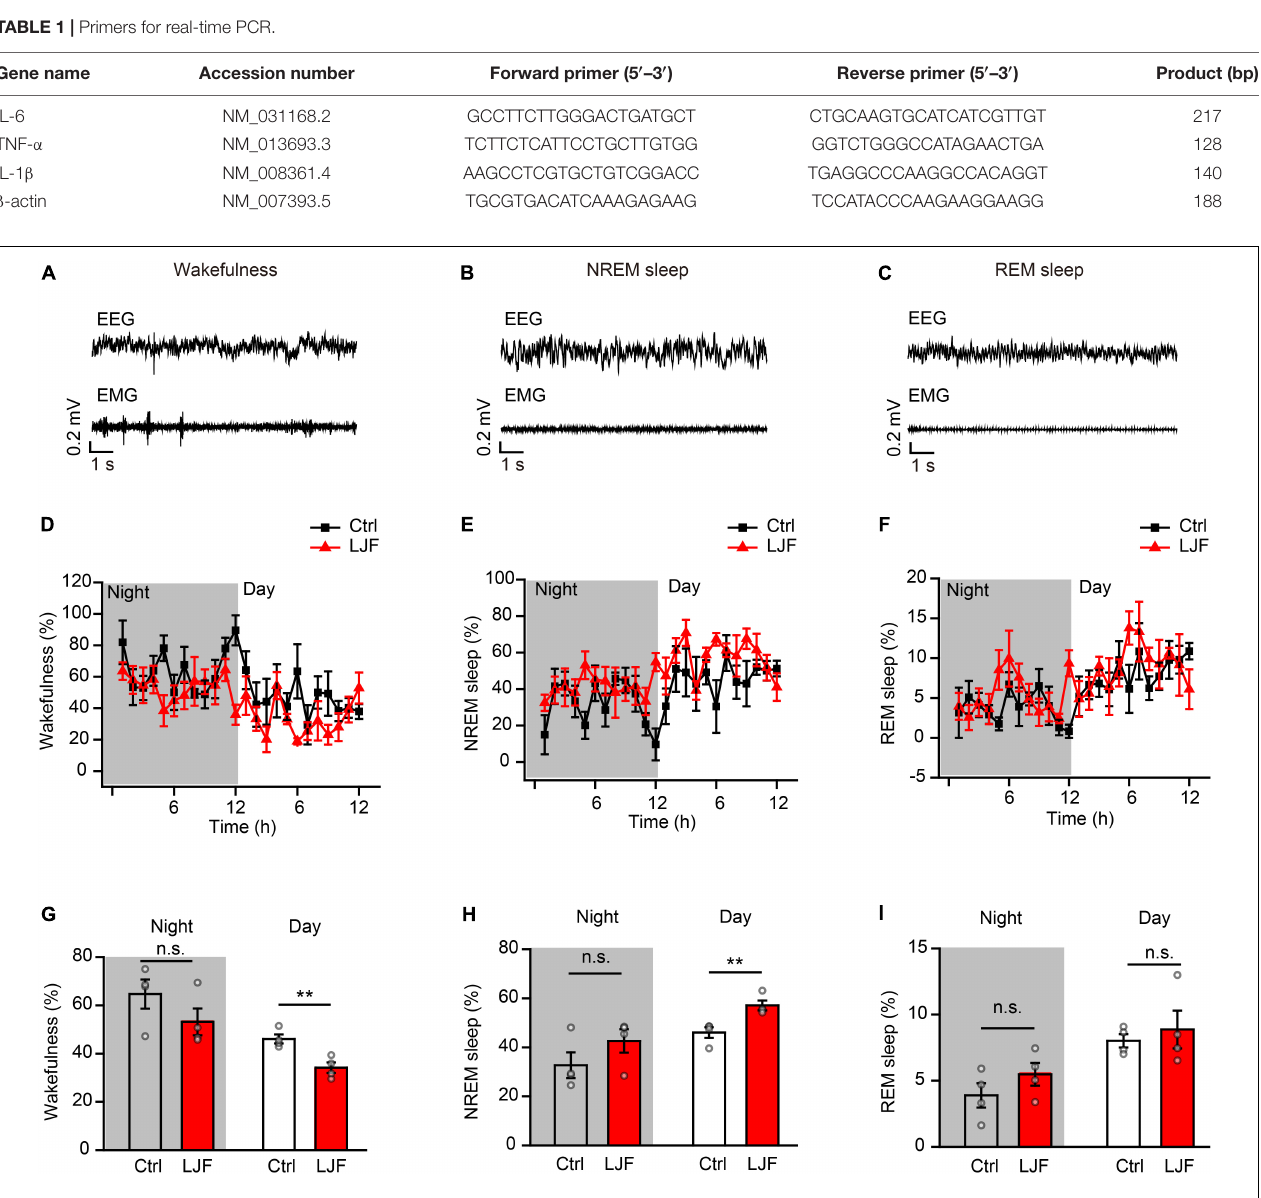
FIGURE 2 | Lonicerae Japonicae Flos (LJF) increases sleep and decreases wakefulness in the basal state. (A–C) Representative EEG and EMG traces during (A) wakefulness, (B) NREM sleep, and (C) REM sleep in the basal state. (D–F) The percentage of time spent in (D) wakefulness, (E) NREM sleep, and (F) REM sleep during night and day in control (Ctrl) and LJF-treated mice. The effects were studied after LJF was administered for 7 days. (G–I) Histogram plots show the time spent by the control and LJF treated mice in wakefulness, NREM sleep and REM sleep states during day and night. Each gray dot represents one mouse. The